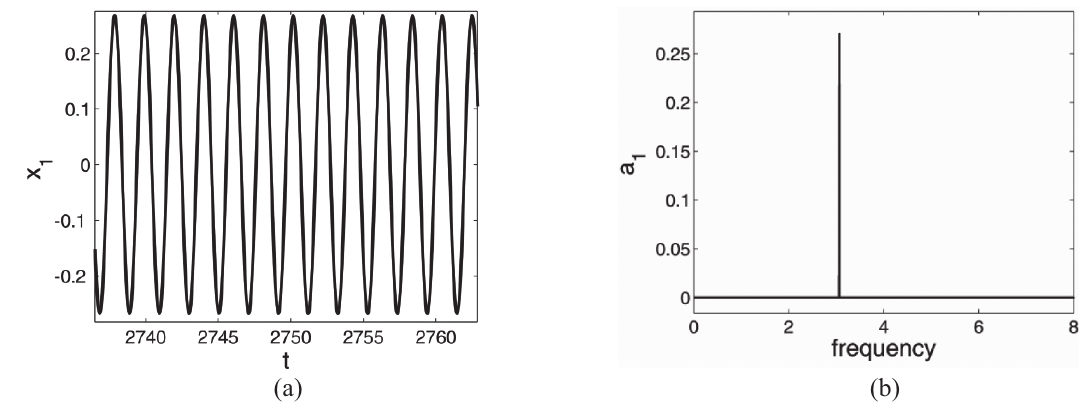
Fig. 4. Time series (a) and fast Fourier transform (b) for periodic beam response; x 0 = 0.01, Ω =